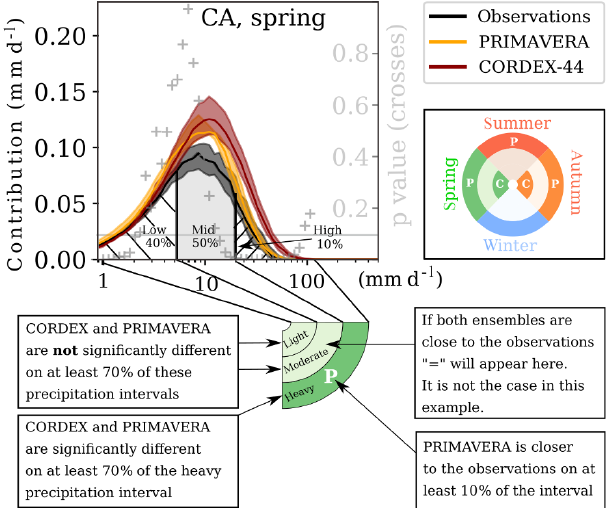
Figure 1. Explanation of the method. Top: daily precipitation con- tribution to mean precipitation (precipitation frequency × bin in- tensity) using exponential bins in the Carpathian region (CA) in spring (MAM) for PRIMAVERA, EUR-44, and observations. The thick lines show the ensemble median, the model spread is calcu- lated on the interquartile range of the inter-member spread, and the observation spread is based on inter-annual values. Grey crosses are p values of the PRIMAVERA versus CORDEX difference using a Student’s t test; the ensembles are significantly different where the crosses are below 0.1. (bottom) For three precipitation inten- sity intervals (light: accounting for lowest 40% of mean precipi- tation; moderate: accounting for the next 50% of the mean; heavy: accounting for highest 10% of the mean), a pie is coloured if the en- sembles differ in more than 70% of the interval. Letters show which ensemble is closest to observations (“P” for PRIMAVERA, “C” for CORDEX; no colour indicates that none of the ensembles are close to observations; “ = ” indicates that both ensembles are close to ob- servations). Right: resulting pie for each region (here CA) and sea-